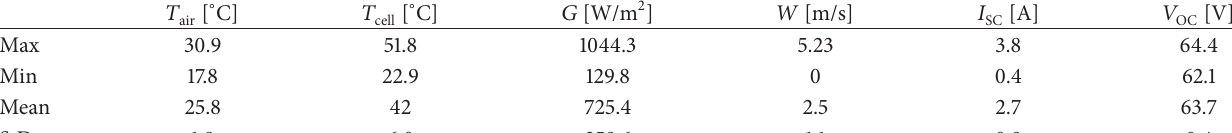
Table 4: Preliminary statistics evaluation of weather, thermal, and electric data pertaining Sanyo panel.